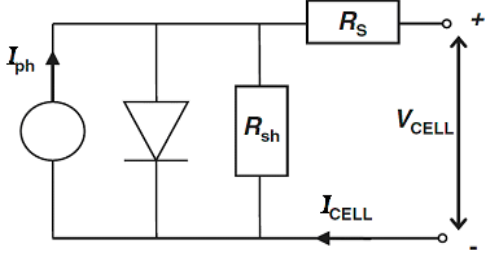
Figure 9. Equivalent circuit model of a solar cell.